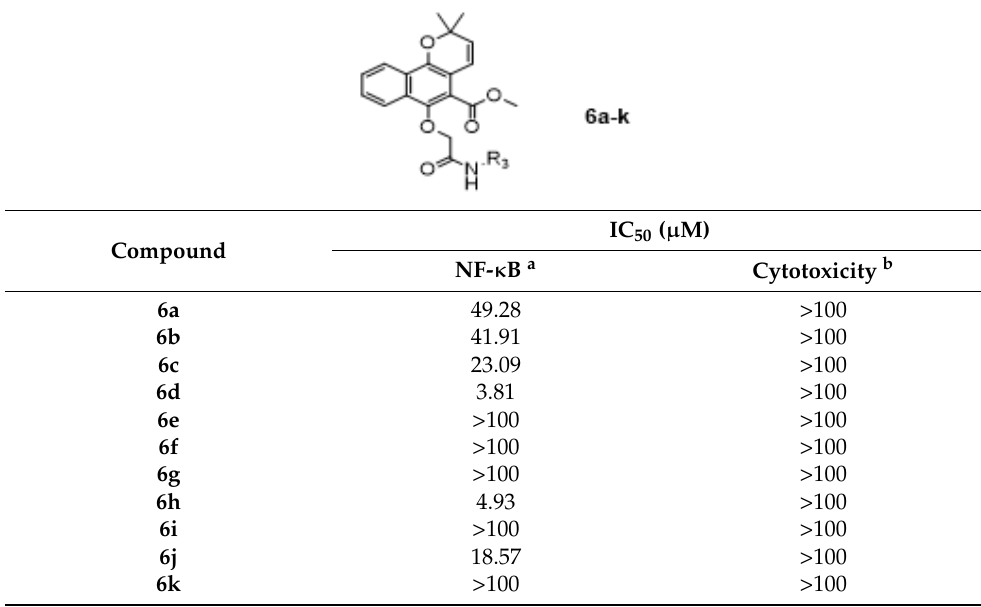
Table 2. In vitro inhibition of NF- κ B transcriptional activity and cytotoxicity of the compounds 6a–k .